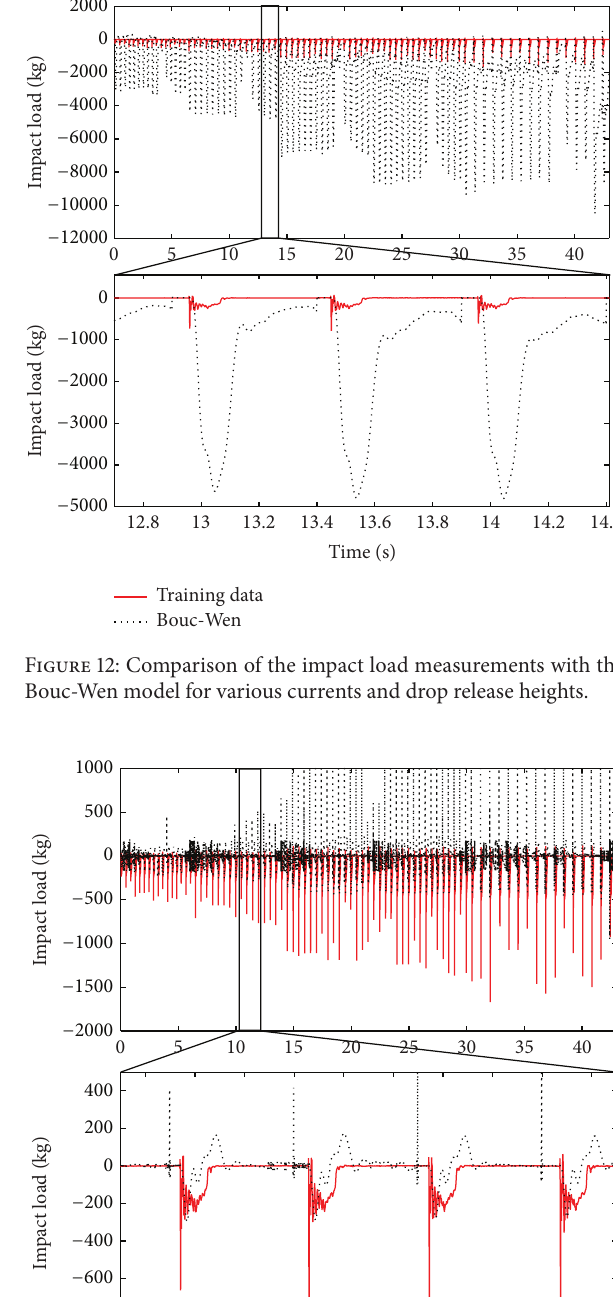
10 are assumed adequate since the modeling performance is satisfied with the 10